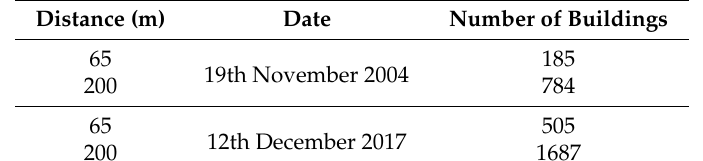
Table 3. Buildings on the shoreline of Phewa lake.